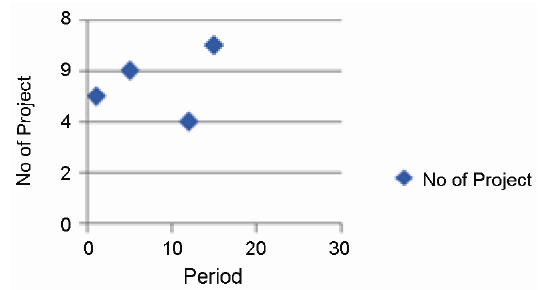
Fig. 4. Scheduling of